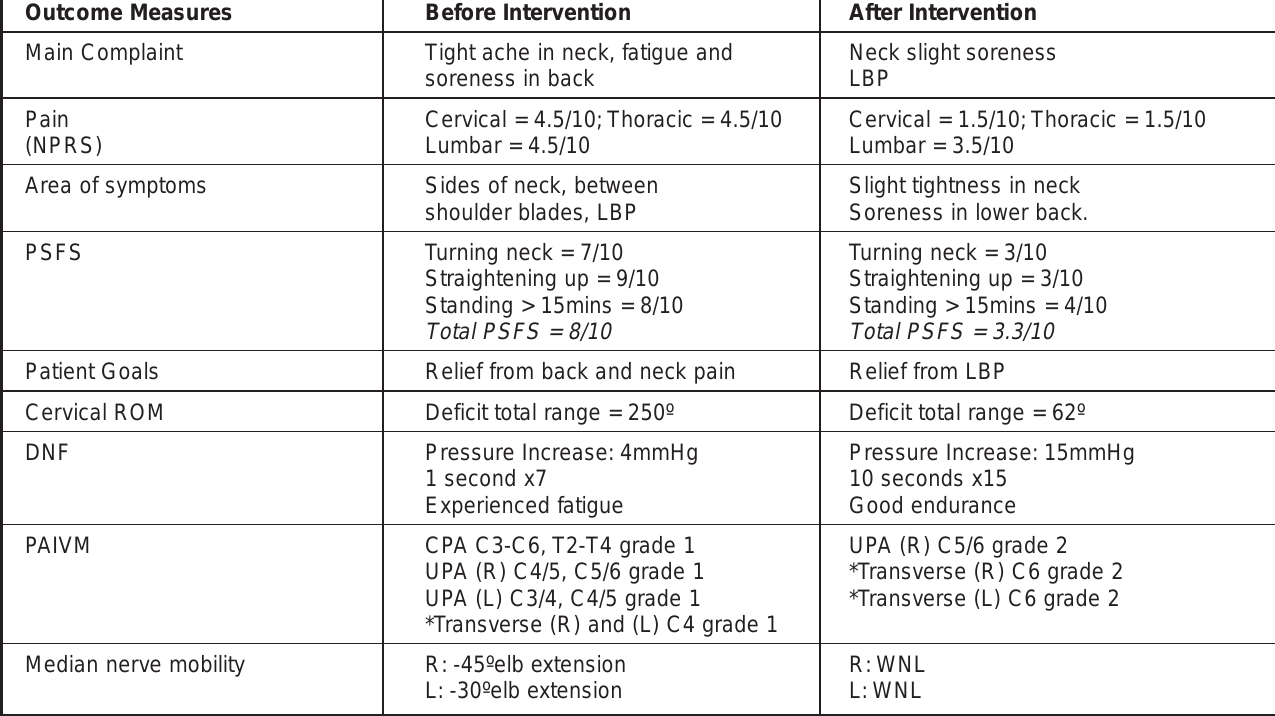
Table 2: A summary of the outcome measures before and after physiotherapy